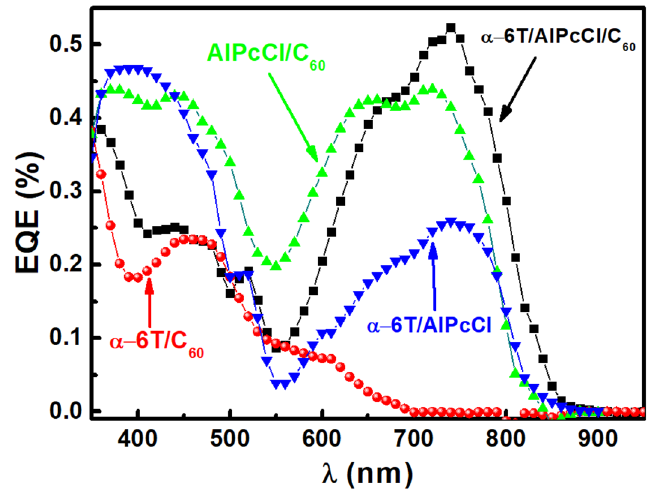
Figure 3. EQE spectra of PHJ-OPVs with different active layers: ( ■ ) α -6T/AlPcCl/C 60 , ( ▲ ) AlPcCl/C 60 , ( ▼ ) α -6T/AlPcCl and ( ● ) α -6T/C 60 .